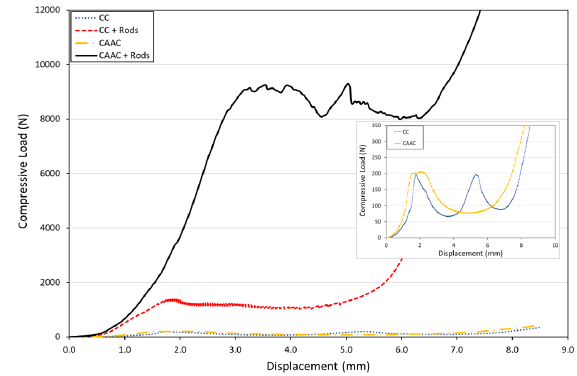
Figure 8: Load-displacement data of panels with two layers of card- board (CC) with and without rods, and two-layers of cardboard and two layers of aluminum in a cardboard-aluminum-aluminum- cardboard stacking structure (CAAC) with and without rods.